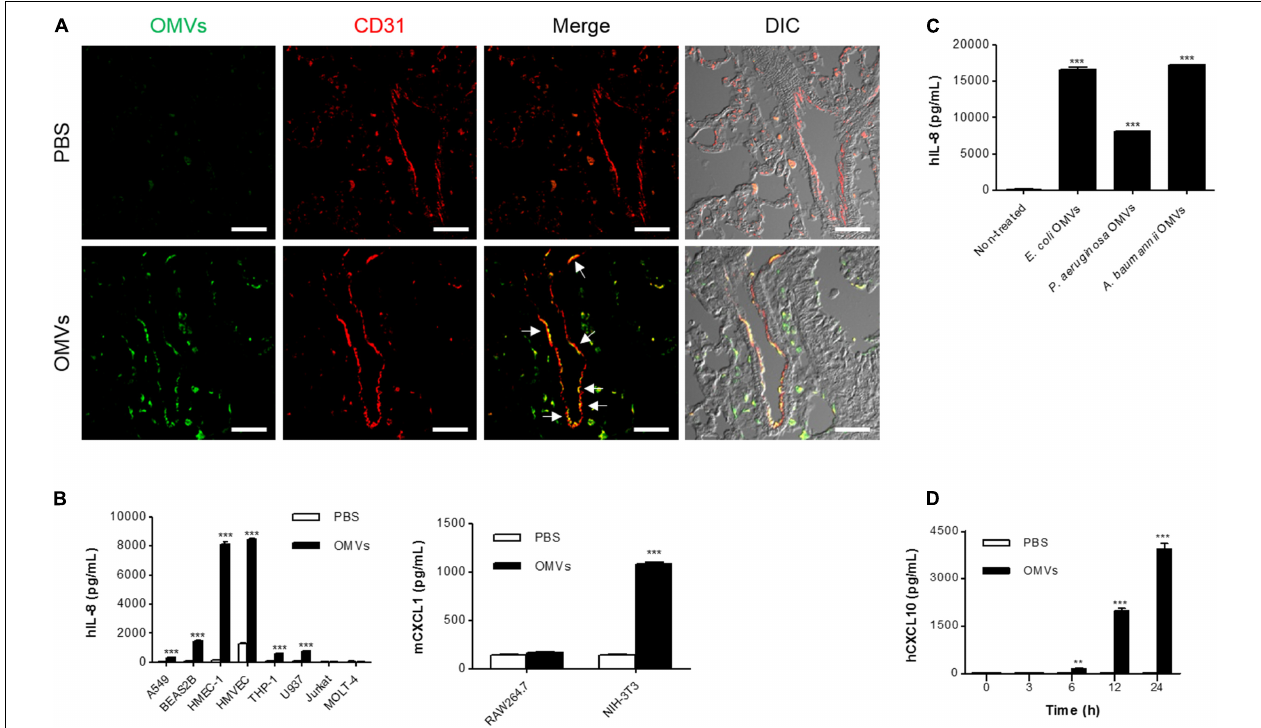
FIGURE 2 | Endothelial cells as main functional targets of OMVs. (A) Wild-type mice were intraperitoneally administered with either PBS or E. coli OMVs (15 µ g in total protein amount per mouse). Five animals were used in each group. At 3 h after OMV administration, the lung tissues were retrieved. The lung sections of five mice were immunostained with anti-OMVs (green; E. coli OMVs) and anti-CD31 (red; endothelial cells) antibodies. Representative fluorescence images are shown here. Scale bars = 30 µ m. White arrows indicate E. coli OMV-positive endothelial cells. (B) After treating E. coli OMVs (0.5 ng/mL in total protein concentration) to various human (A549, BEAS2B, HMEC-1, HMVEC, THP-1, U937, Jurkat, and MOLT-4) and mouse cells (RAW264.7 and NIH-3T3), the concentrations of human IL-8 or mouse CXCL1 were measured in the culture supernatants by ELISA ( n = 3). (C) After treating various OMVs ( E. coli , P. aeruginosa , and A. baumannii OMVs; 0.5 ng/mL in total protein concentration) to human HMEC-1 endothelial cells, the concentration of human IL-8 was measured in the culture supernatants by ELISA ( n = 3). (D) After treating E. coli OMVs (0.5 ng/mL in total protein concentration) to human HMEC-1 endothelial cells, the concentrations of human CXCL10 were measured in the culture supernatants by ELISA ( n = 3). Data were represented as mean ± SEM. ∗∗ P < 0.01 and ∗∗∗ P < 0.001, respectively, calculated by two-way (B,D) or one-way ANOVA (C) with Bonferroni correction for multiple comparisons.